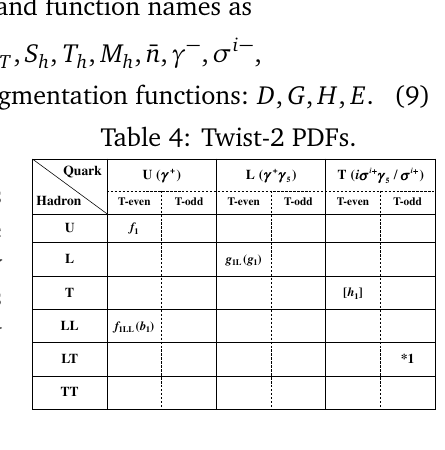
Table 5: Twist-3 PDFs.